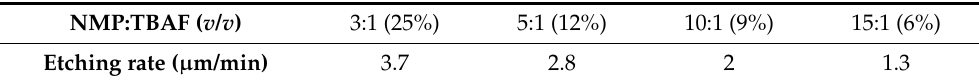
Table 1. PDMS wet-etching rates using TBAF solution.